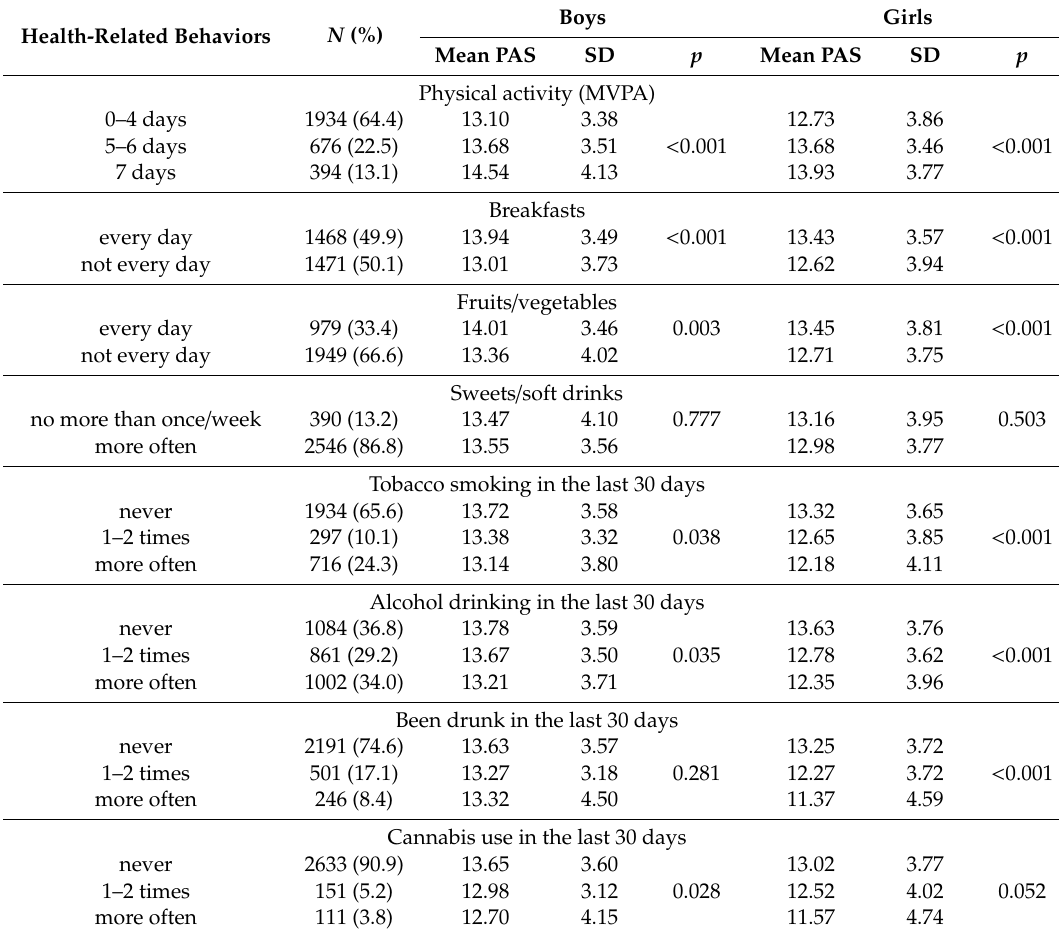
Table 1. Mean crude Positive Attitude Scale (PAS) scores according to health-related behaviors by